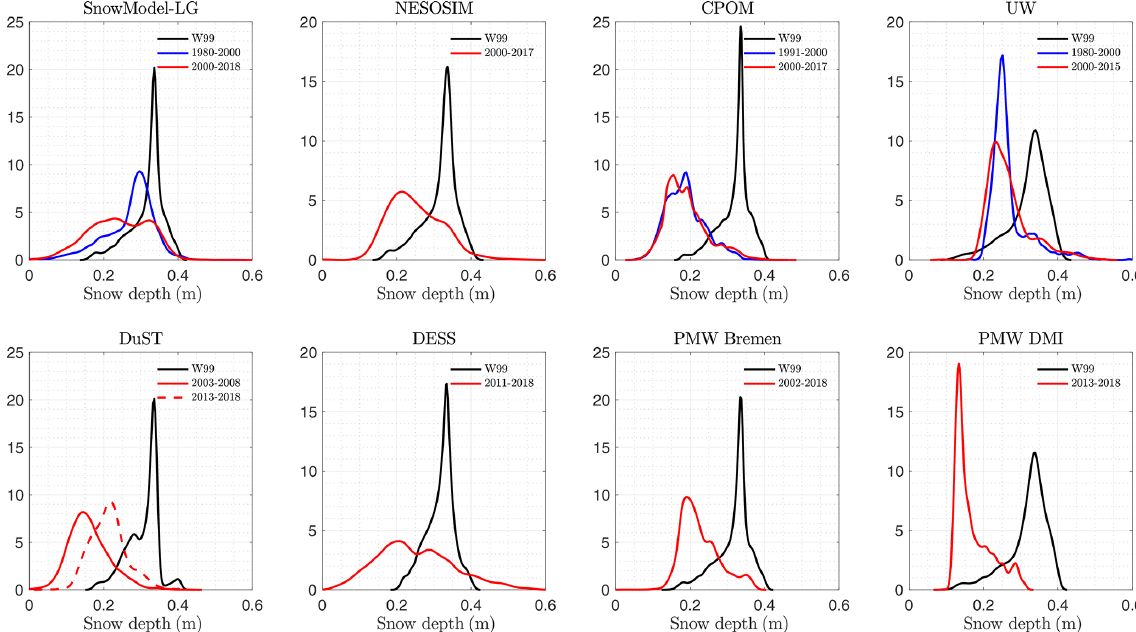
Figure 5. Snow distribution comparison between W 99 and snow products in spring (March and/or